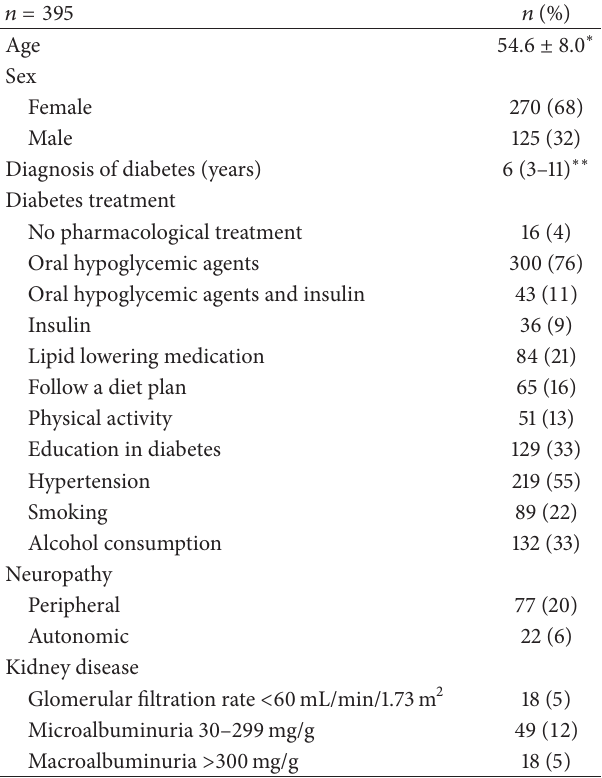
Table 1: Sociodemographic characteristics and comorbidity in type 2 diabetes